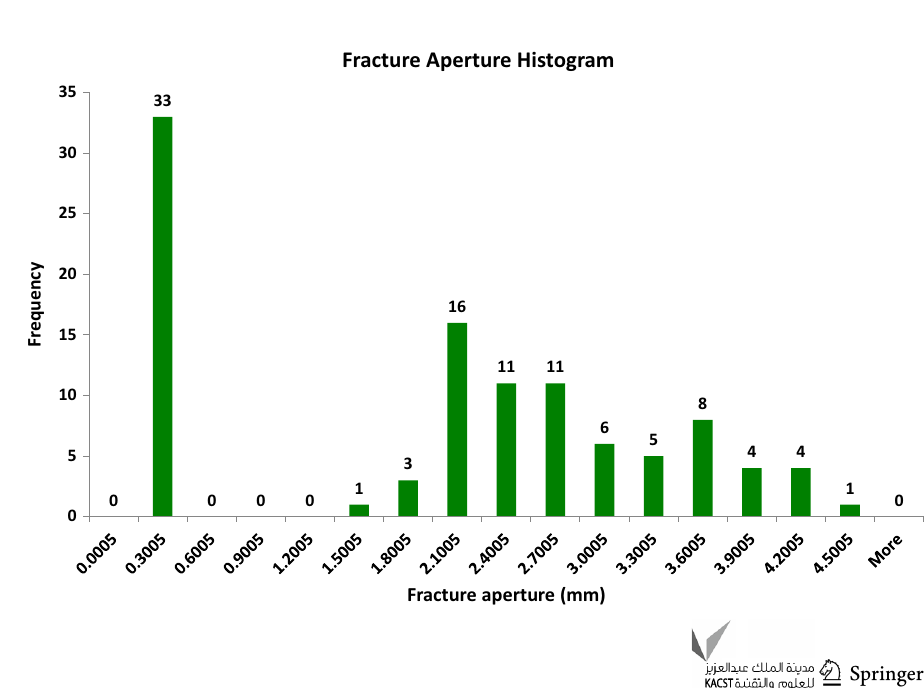
Fig. 3 Fracture aperture histo- gram derived from the FMI